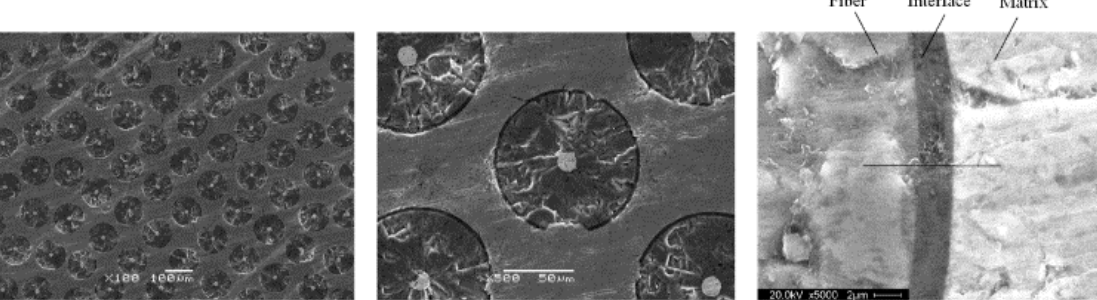
Figure 10. Micro-morphology of SIC long fiber titanium matrix reinforced composite material. The interfacial strength of the fiber push-out process can be described and predicted by a fiber-matrix-composite three-phase model. As shown in Figure 11, the fiber glass slide sample is placed on a slotted base and a three-cylinder model is adopted.